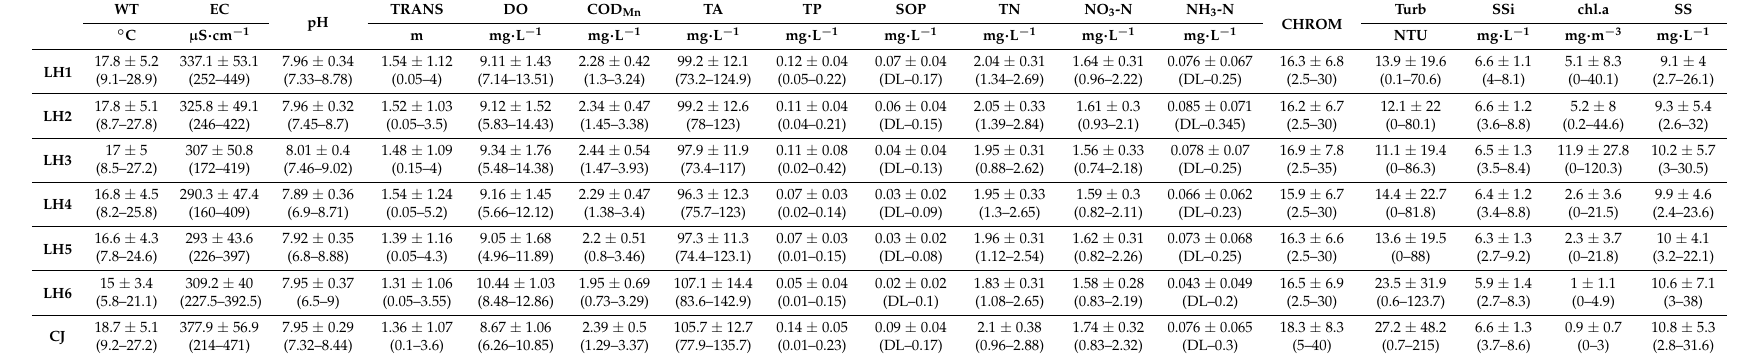
Table 1. Statistics table of water environment variables sampled from Long River Bay (LRB), China.